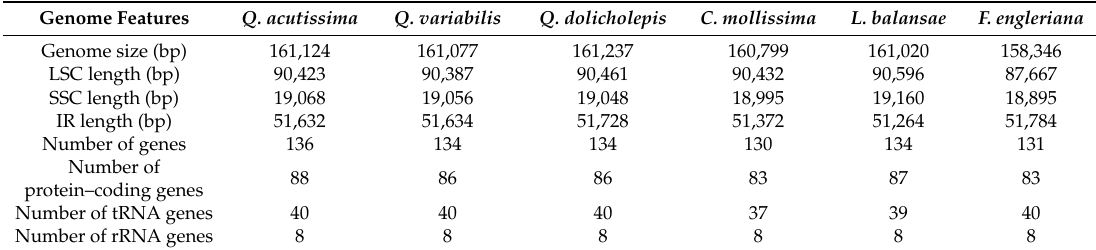
Figure 1. Chloroplast genome map of Q. acutissima . Genes inside the circle are transcribed clockwise, and those outside are transcribed counterclockwise. Genes of different functions are color-coded. The darker gray in the inner circle shows the GC content, while the lighter gray shows the AT content. Table 1. Summary of five Quercus chloroplast genome features.